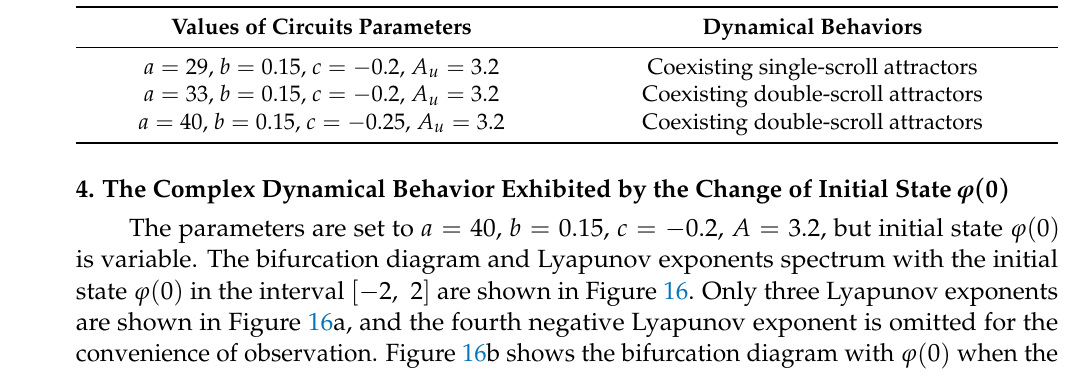
Table 1. The values of circuit parameters for various dynamical